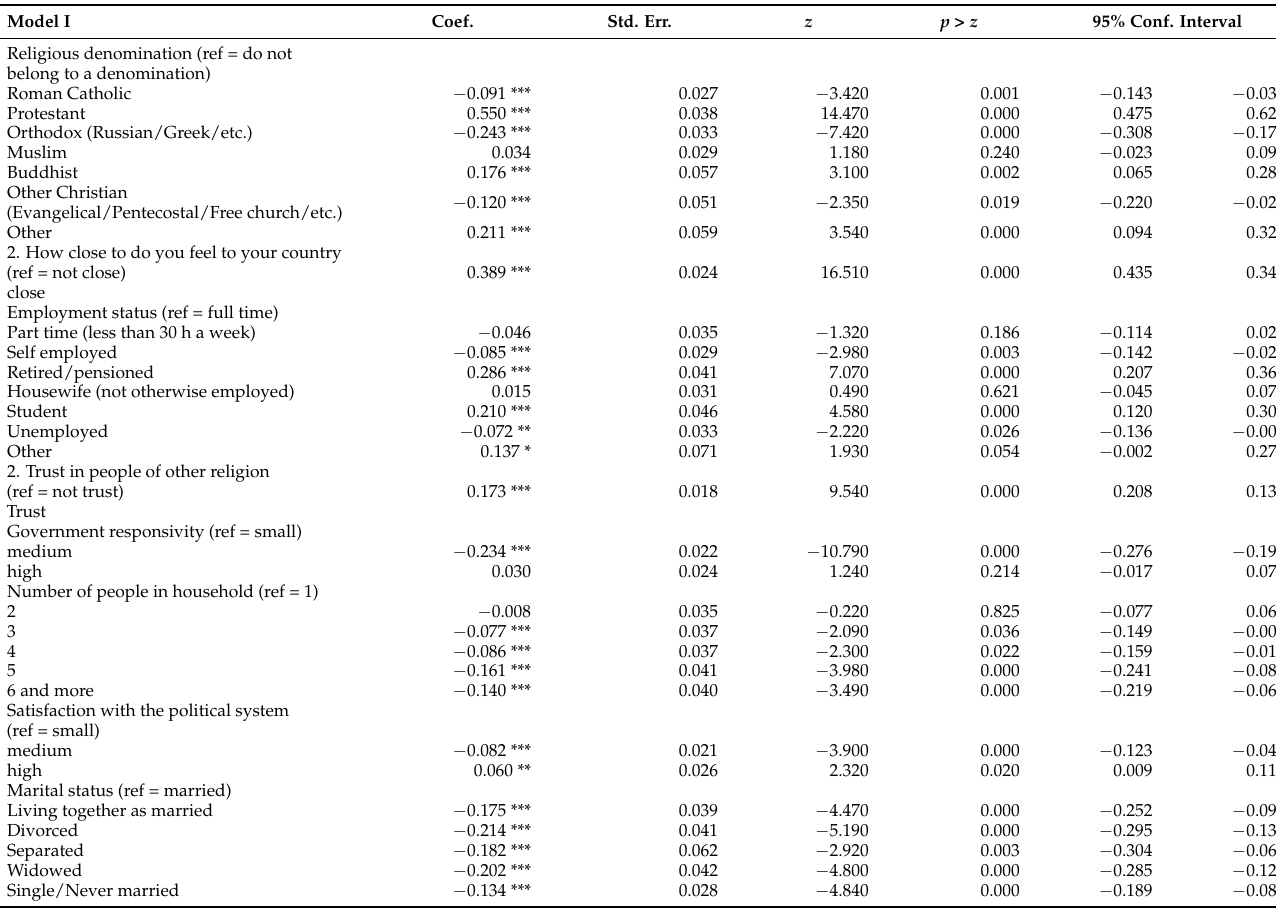
Table A3. The empirical results of tax morality logistic regression model with interaction effects based on mutual information variable selection